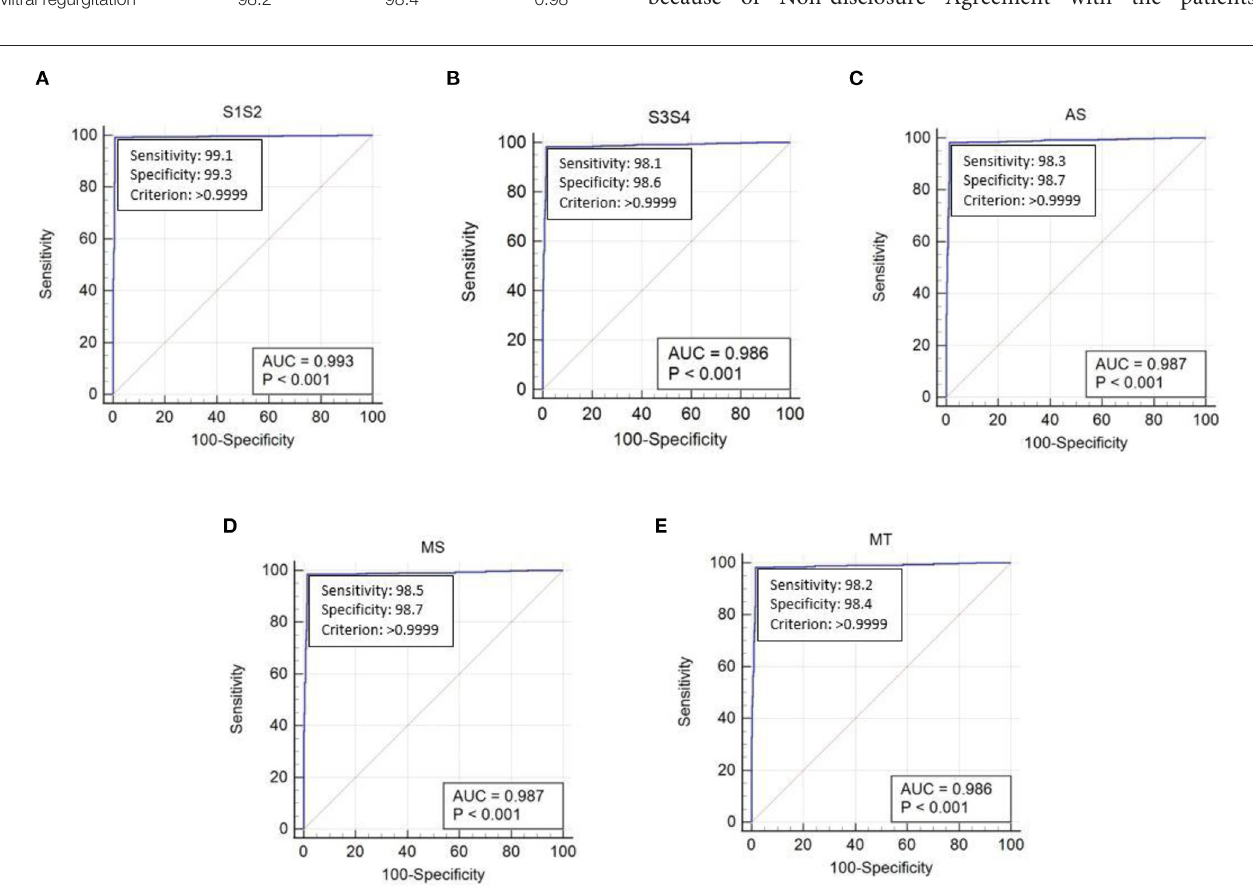
FIGURE 16 | The receiver operating characteristic (ROC) curve analysis of heart sound components with ID function of the neuron model (A) first and second heart sound, (B) third and fourth heart sound, (C) aortic stenosis, (D) mitral stenosis, and (E) mitral regurgitation.